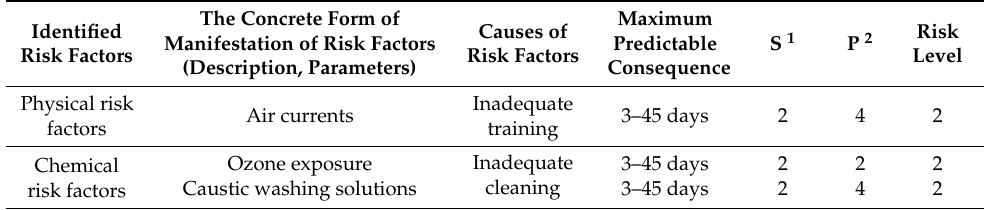
Table 2. Analysis and evaluation of the risks of injury and occupational disease related to the factors of the working